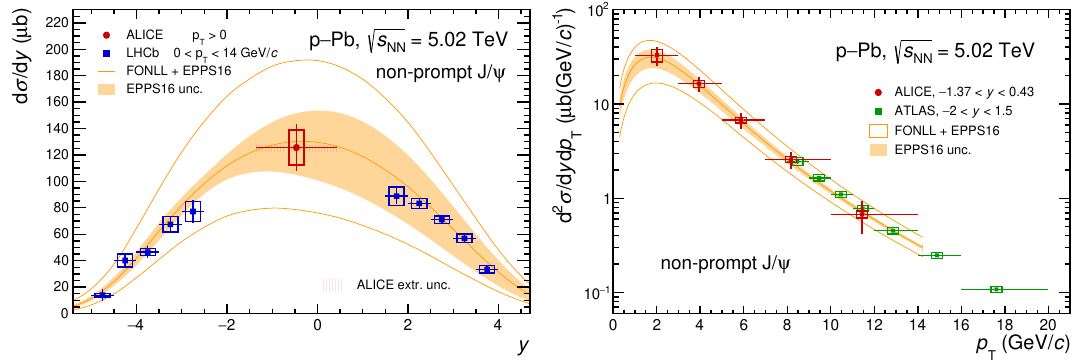
Figure 6 . d σ / d y as a function of rapidity (left panel) as obtained at midrapidity in this J /ψ from h b work for p > 0 and by the LHCb collaboration in the forward and backward rapidity regions [64] T for 0 < p < 14 GeV/ c , and d 2 σ / d y d p as a function of p (right panel) compared T J /ψ from h b T T with ATLAS measurements [14] (shown up to p = 20 GeV/ c ). The statistical and systematic T uncertainties are shown as vertical error bars and hollow boxes, respectively. The extrapolation uncertainty related to the procedure to go from the visible region ( p > 1 GeV/ c ) to p > 0 for the T T ALICE data point in the left panel is indicated with a dashed band. For the measurements as a function of p , data symbols are placed at the mean value of the p distribution within each bin. T T The results are compared to FONLL computations [90] with EPPS16 [95] nPDFs, highlighting the total theoretical uncertainty (empty band) and the contribution from EPPS16 (coloured band). In the right panel, model computations are obtained in the same rapidity range of the ALICE results, namely − 1 . 37 < y < 0 . 43